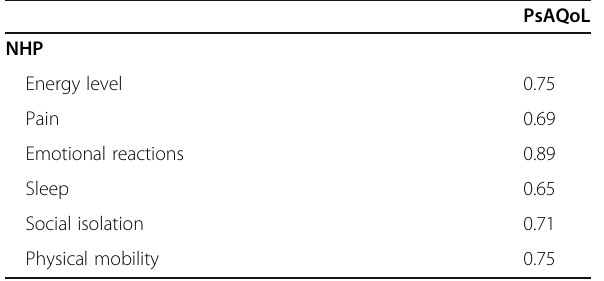
Table 3 Association between PsAQoL and NHP section scores ( n = 52)